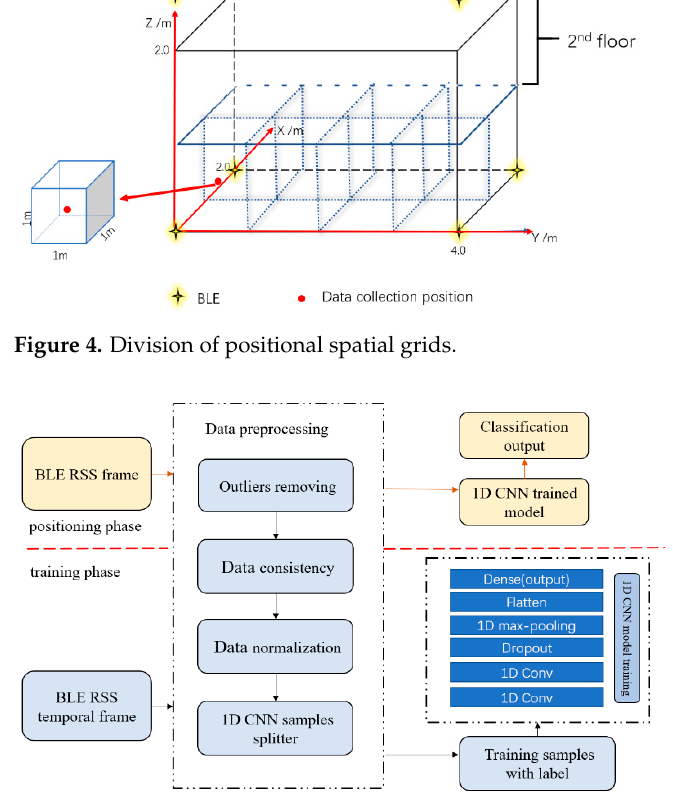
Figure 5. Layout of proposed scheme.